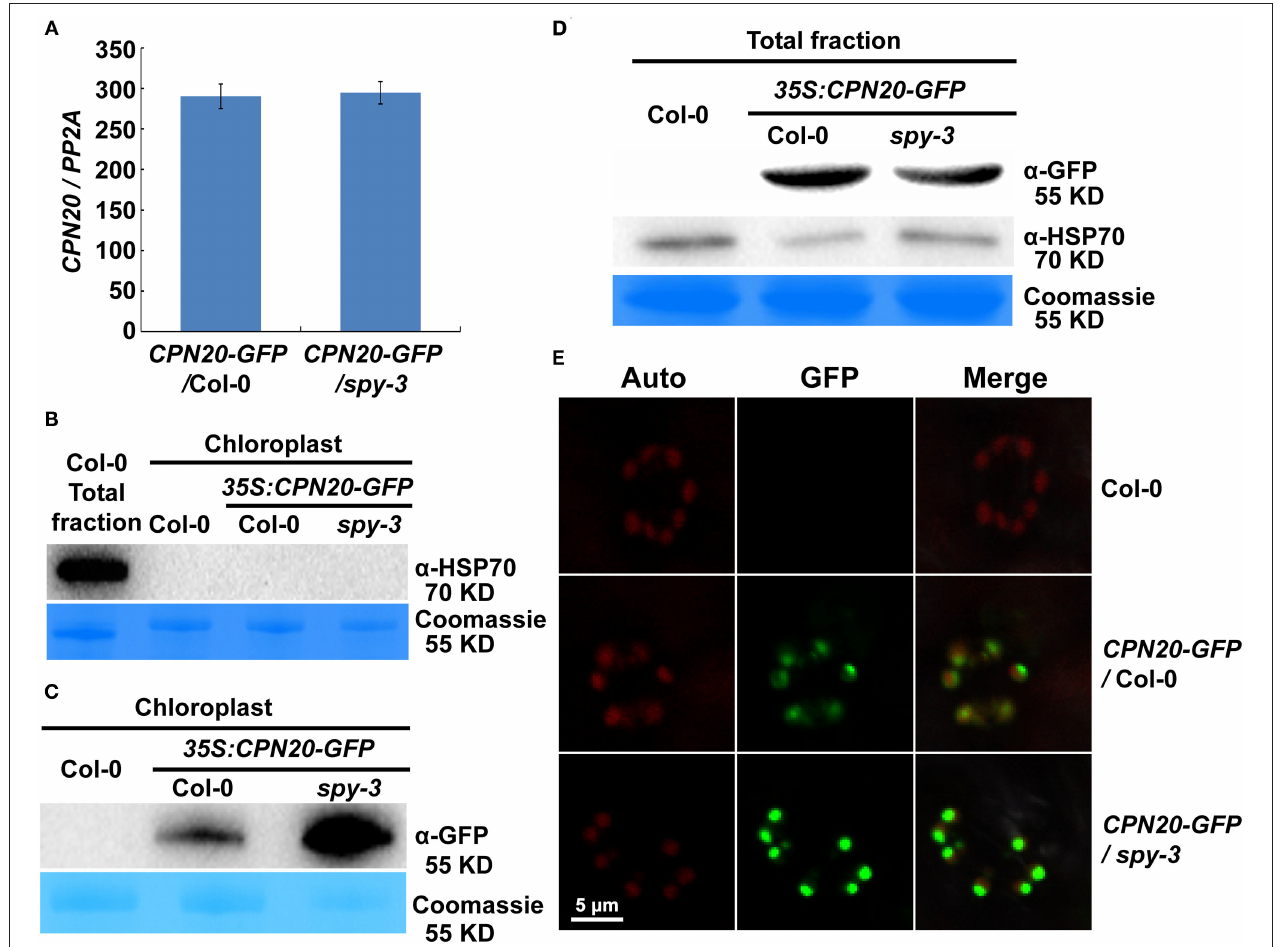
FIGURE 4 | SPY regulates the accumulation of CPN20 in guard cells and mesophyll cell chloroplasts. (A) mRNA level of CPN20 in different transgenic materials. CPN20-GFP /Col-0 or CPN20-GFP/spy-3 represents the CPN20 -overexpressing line in the background of Col-0 or and spy-3 . (B) Purity of chloroplasts confirmed by cytosolic marker protein HSP70 on western blot. Total proteins and chloroplast proteins were isolated from leaves of indicated materials before being subjected to SDS PAGE and western blotting using α -HSP70. Coomassie blue staining of RbcL was used as a loading control. (C) CPN20 is more abundant in chloroplasts from spy-3 . GFP-tagged CPN20 was detected by α -GFP while coomassie blue staining of RbcL was used as a loading control. (D) Total CPN20 abundance is largely unchanged in CPN20-GFP / spy-3 compared with CPN20-GFP /Col-0. CPN20-GFP fusion proteins in extracts from indicated genotypes were detected by western blotting using α -GFP or α -HSP70. Coomassie blue staining of RbcL was used as a loading control. (E) GFP fluorescence of CPN20-GFP in chloroplasts of stomatal guard cells in CPN20-GFP /Col-0 and CPN20-GFP / spy-3 . Leaves of 40-day-old plants were observed under a confocal microscope using identical parameters. Auto, GFP, and Merge indicate chlorophyll autofluorescence, the fluorescence of CPN20-GFP, and merged image of Auto and